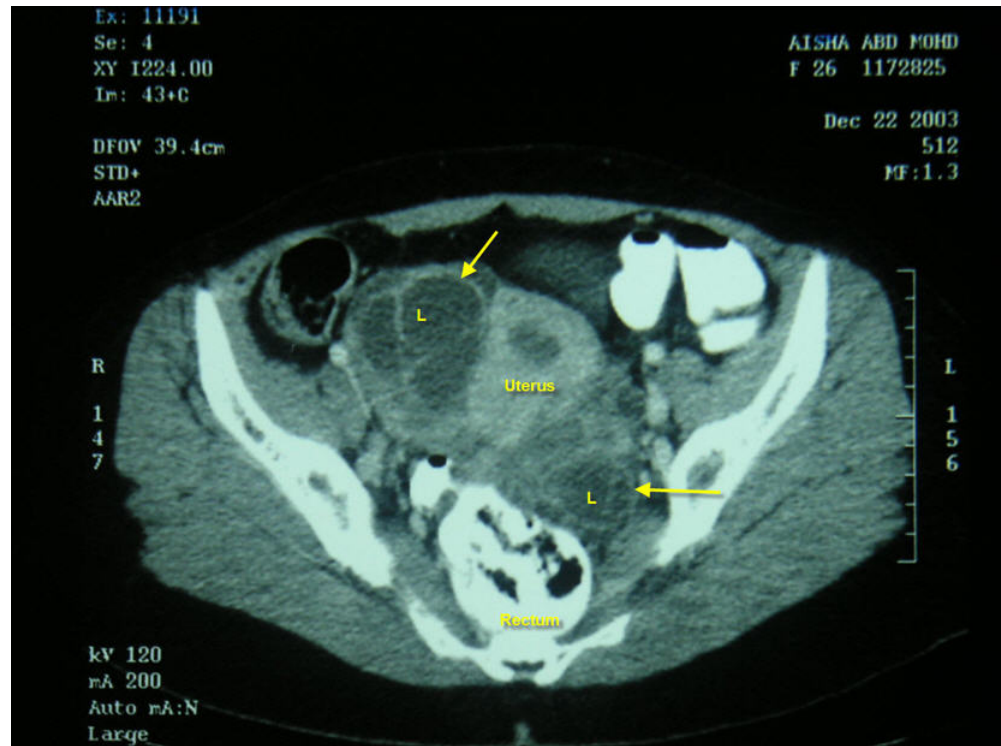
FIGURE 2. CT scan showing multiple septated cystic lesions in both the